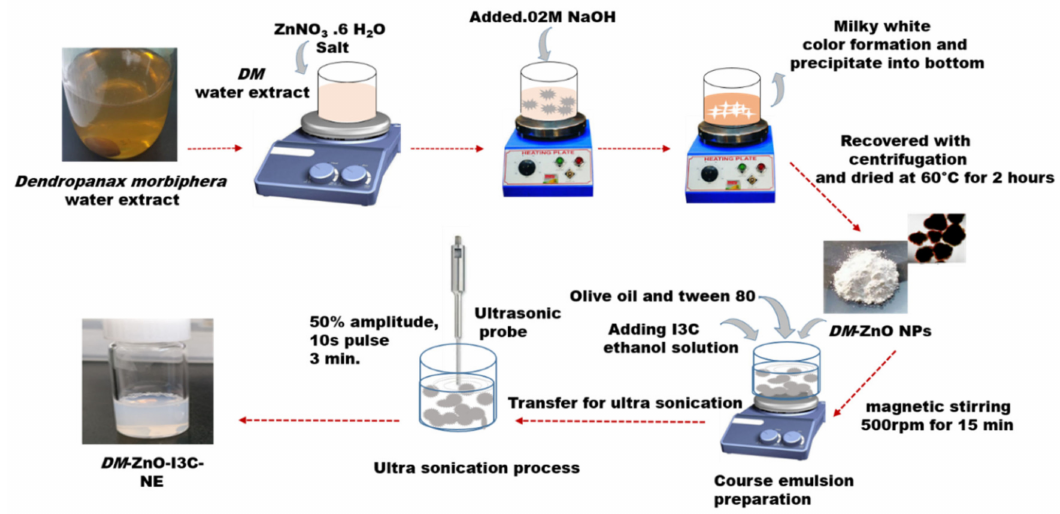
Figure 1. Preparation of DM -ZnO-I3C oil in water nanoemulsion using the ultrasonication